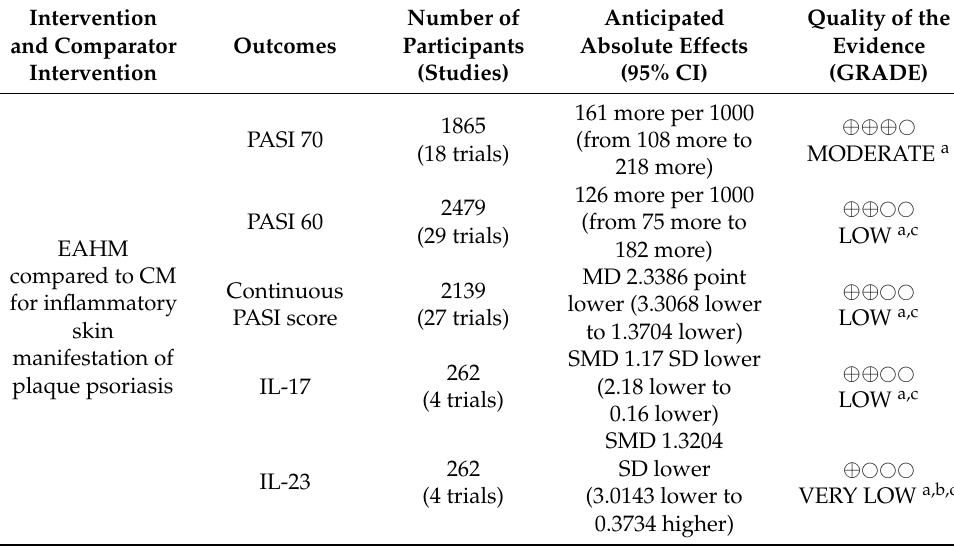
Table 4. Summary of findings for studies meta-analysis.